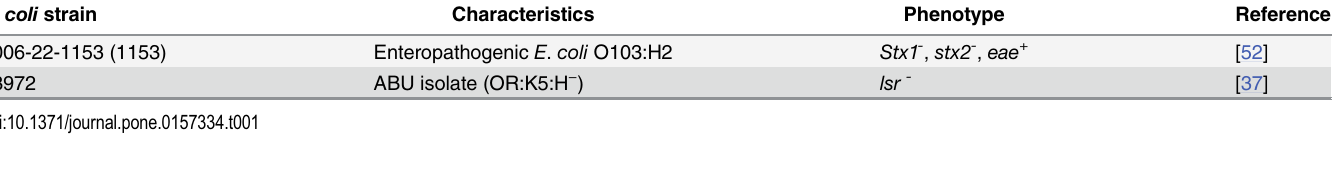
Table 1. Bacterial strains used in this study. E . coli